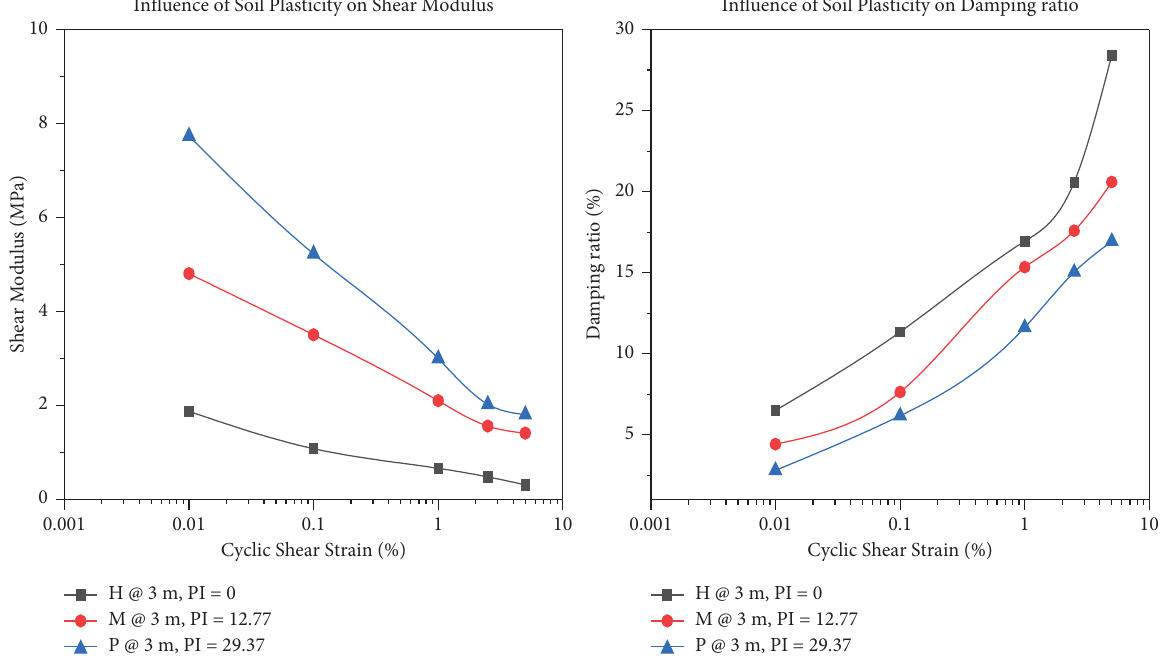
Figure 11: Infuence of soil plasticity on shear modulus and damping ratio values at the 5th cycle and 150kPa. Comparison of G/G value of Awash Melkasa soil max with saturated clay of Seed and Idriss